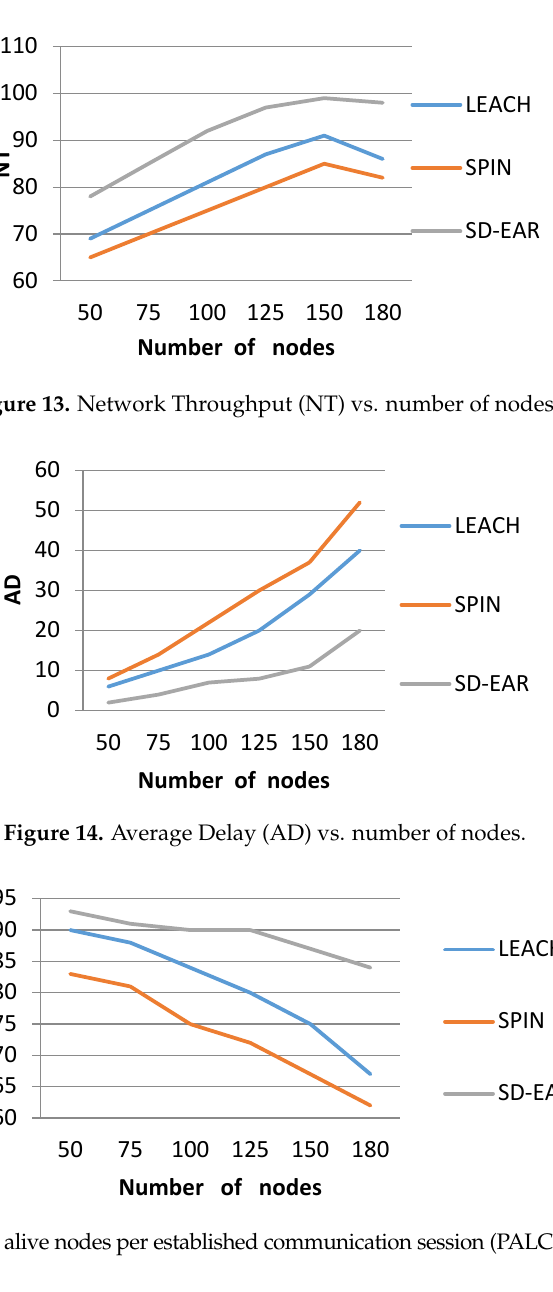
Figure 12. Overall Energy Consumed (OEC) vs. number of nodes. Appl. Sci. 2018 , 8 , x FOR PEER REVIEW